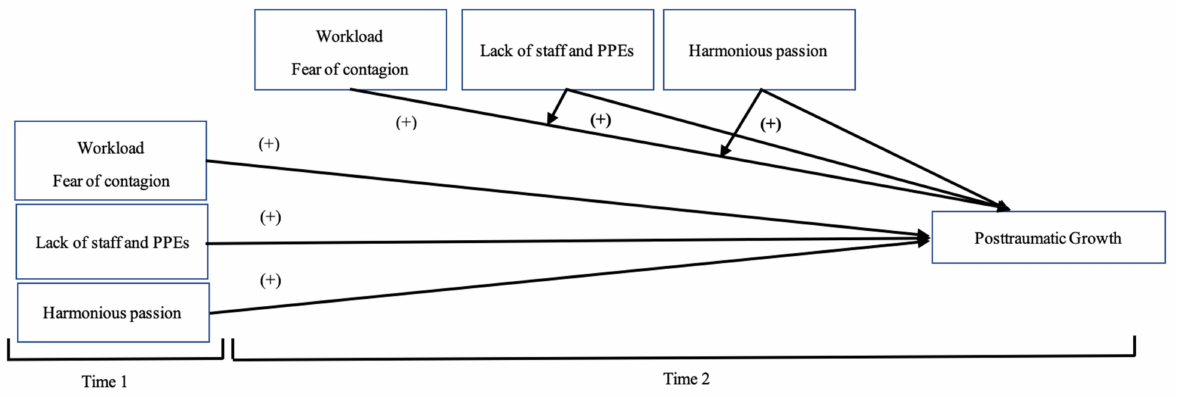
Figure 2. The proposed research model for predicting posttraumatic growth in the face of